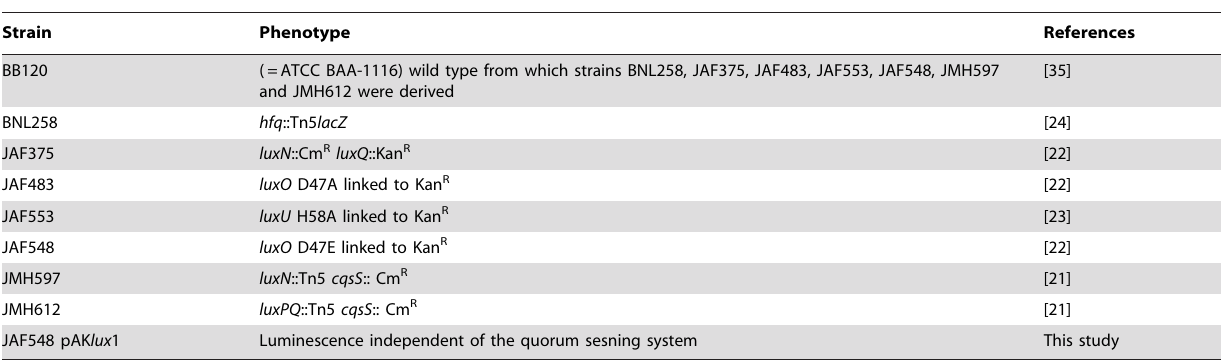
Table 3. V. harveyi strains used in this